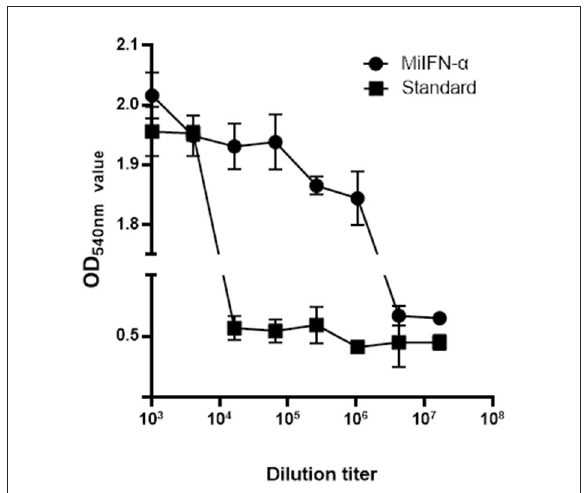
FIGURE6 Observation of cell staining with crystal violet. Adherent F81 cells were stained with 0.5% crystal violet, which rendered the viable cells blue-violet; the non-colored dead cells were washed away with the effluent. Results of absorbance detection at 540nm show that the antiviral activity of standard canine IFN- α (2 × 10 6 IU/mL) decreased significantly at 4 6 dilutions and that of mink IFN- α slowly decreased at 4 9 dilutions.